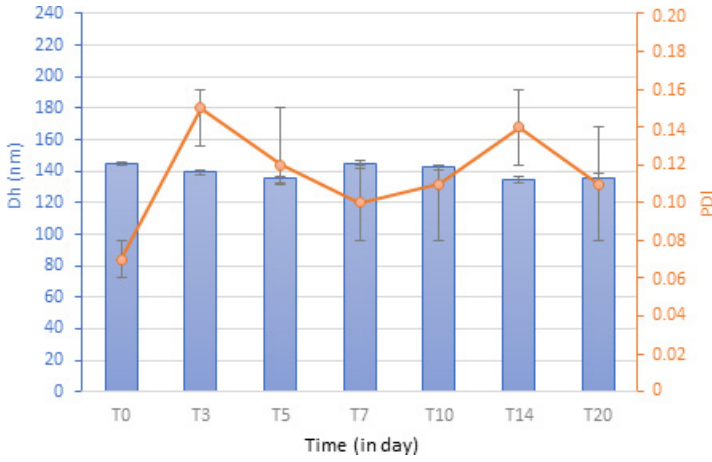
Figure 6. Evolution of Dh and PDI of Ni8C12-loaded PMLABe73-based NPs with storage time at 4 °C.